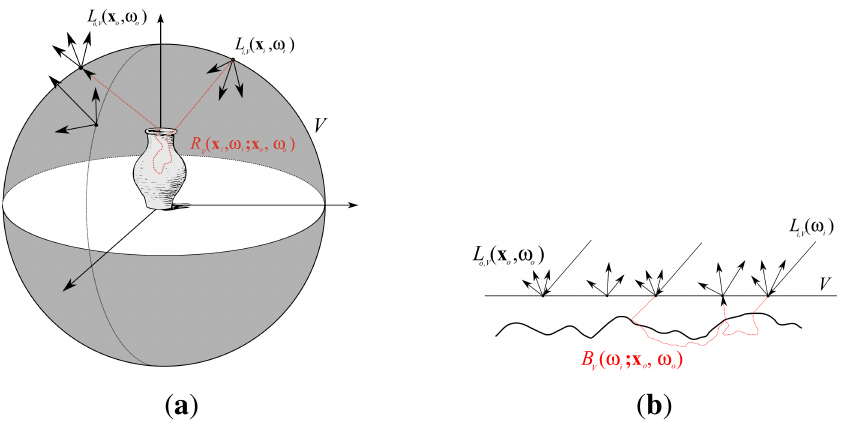
Figure 2. Illustration of the observation that the outgoing light field L o,V ( x o , ω o ) depends on the incident light field L i,V ( x i , ω i ) , both parameterized over the surface of the bounding volume V . This dependency is fully described as the reflectance field R V ( x i , ω i ; x o , ω o )